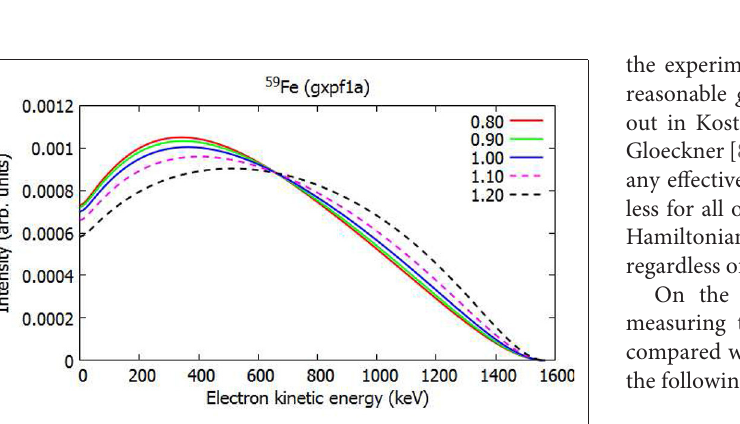
FIGURE 11 | Normalized ISM-computed electron spectra for the first-forbidden non-unique β − decays of 138 Cs and 93 Y. The value g V color coding represents the value of g A and the dash coding the value of the mesonic enhancement factor ǫ MEC .